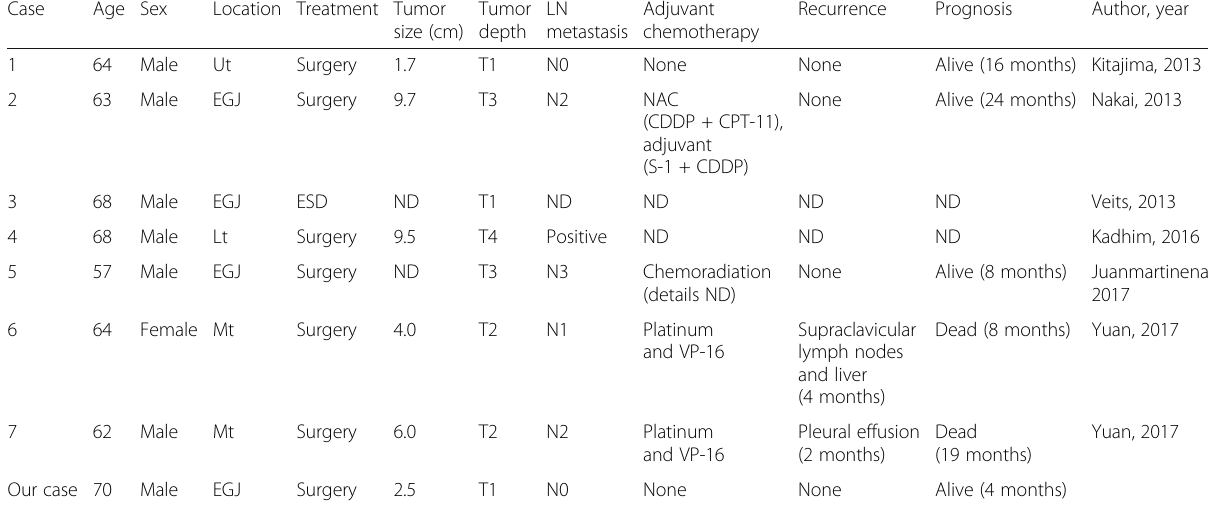
Table 1 Previously reported cases of esophageal or esophagogastric MANEC